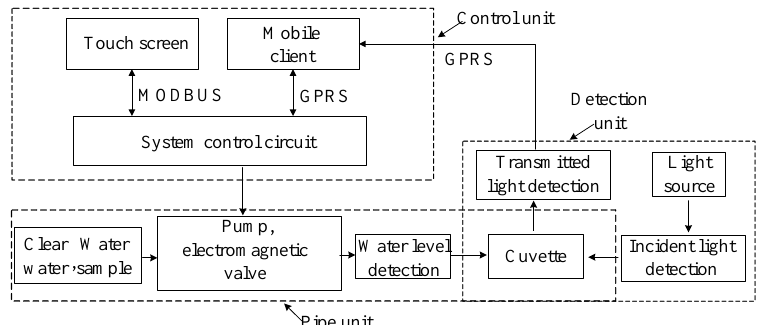
Figure 6. Instrument system block diagram.